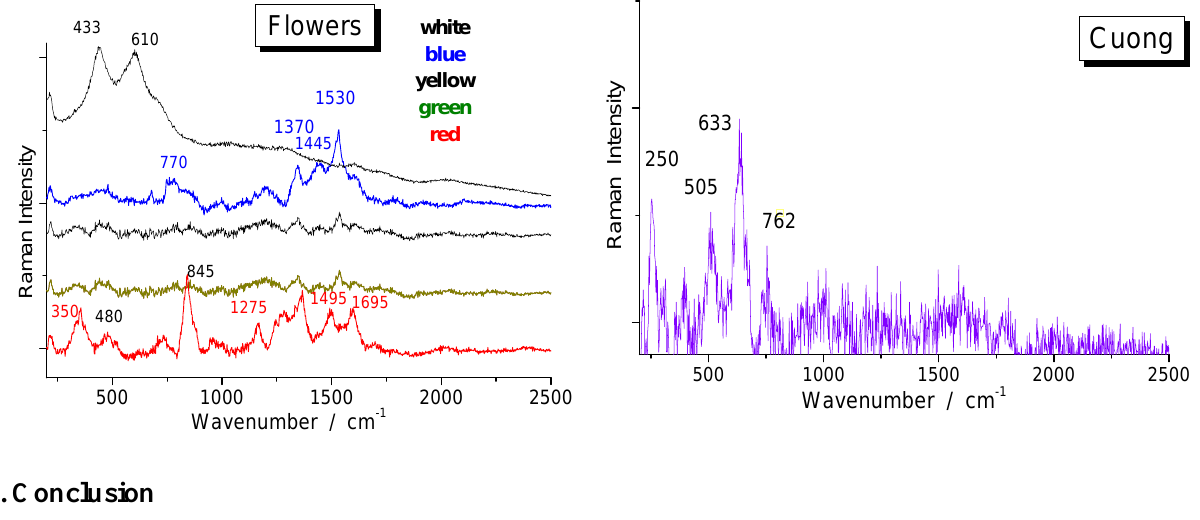
Figure 8. Representative raw Raman signature recorded with 785 nm mobile Raman